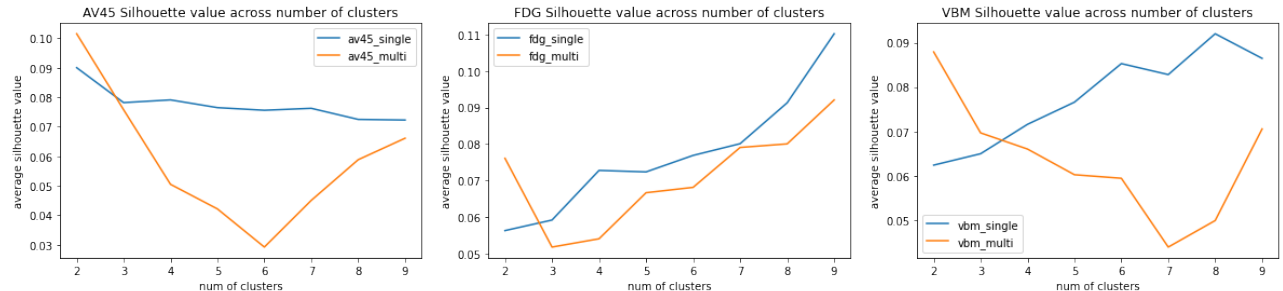
Figure 3. Averaged Silhouette scoring of single-graph and multigraph clustering results across 5 scoring functions × 5 comparison groups at each number of cluster. The results of analyzing AV45, FDG, and VBM data are shown from left to right. In the subsequent analyses, we report the multigraph results of clustering SNPs into two groups, which is the optimal case for both AV45 and VBM.